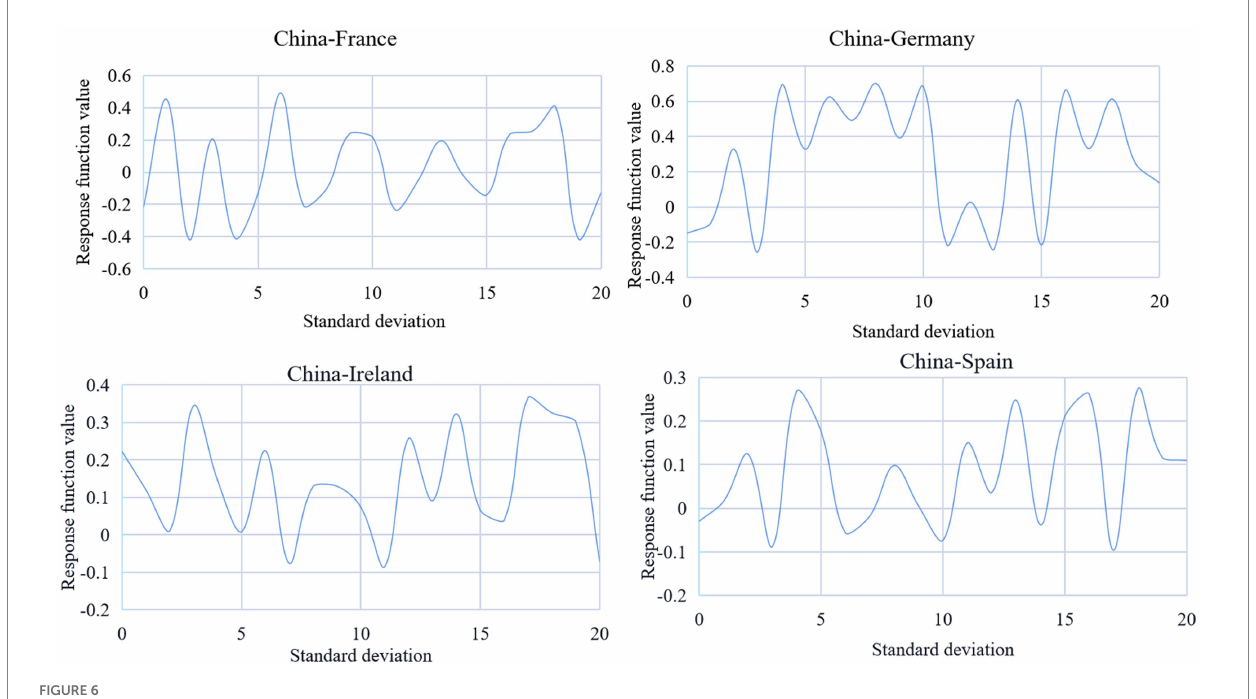
FIGURE 6 The influence of China’s economic growth on CDE, a representative